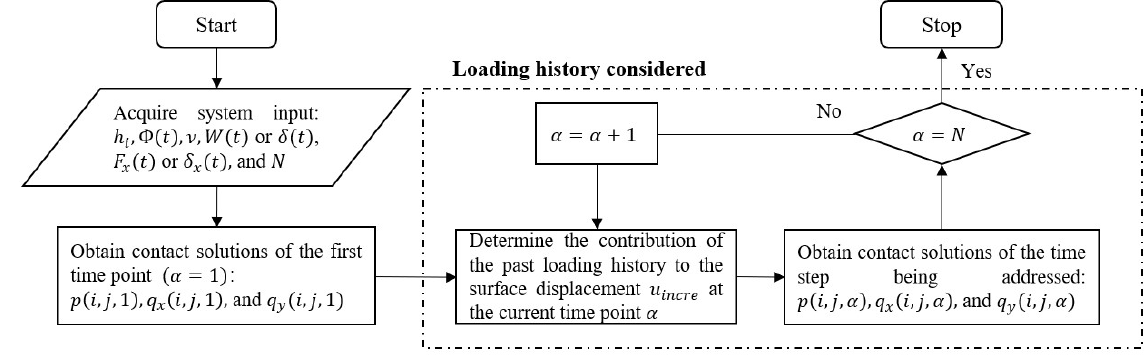
Figure 3. Flow chart of the algorithm for the viscoelastic partial slip contact problems.